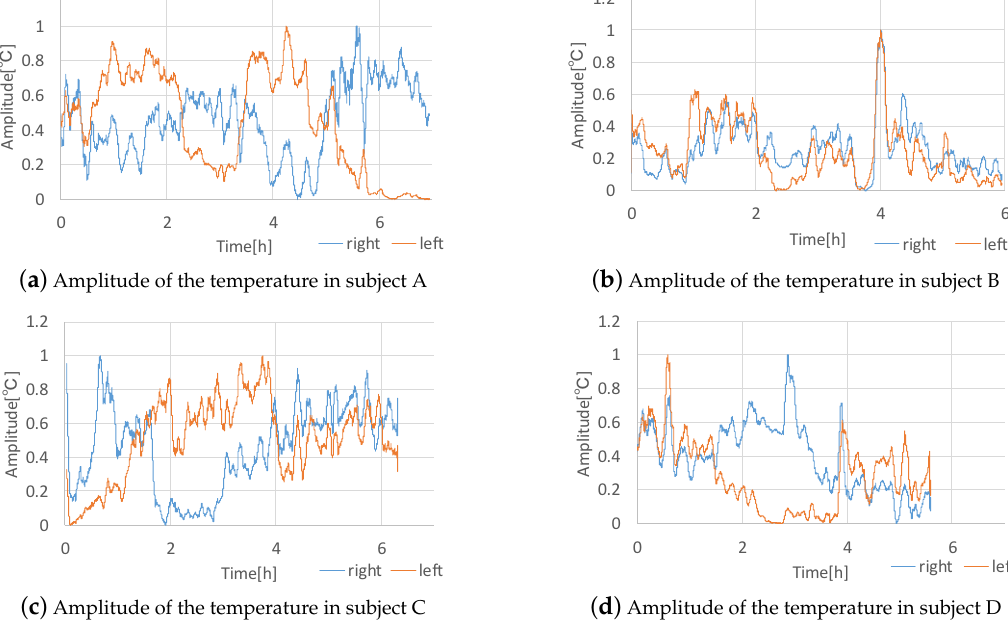
Figure 9. Results of subjects’ temperature